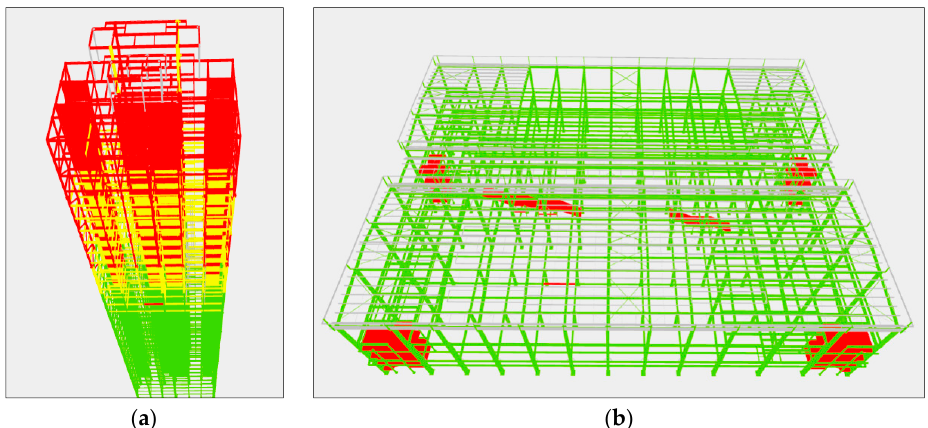
Figure 11. Progress management ( a ) 4D model of the Jinjian Yingxi Garden-1# Building Steel Structure Project; ( b ) 4D model of another project.